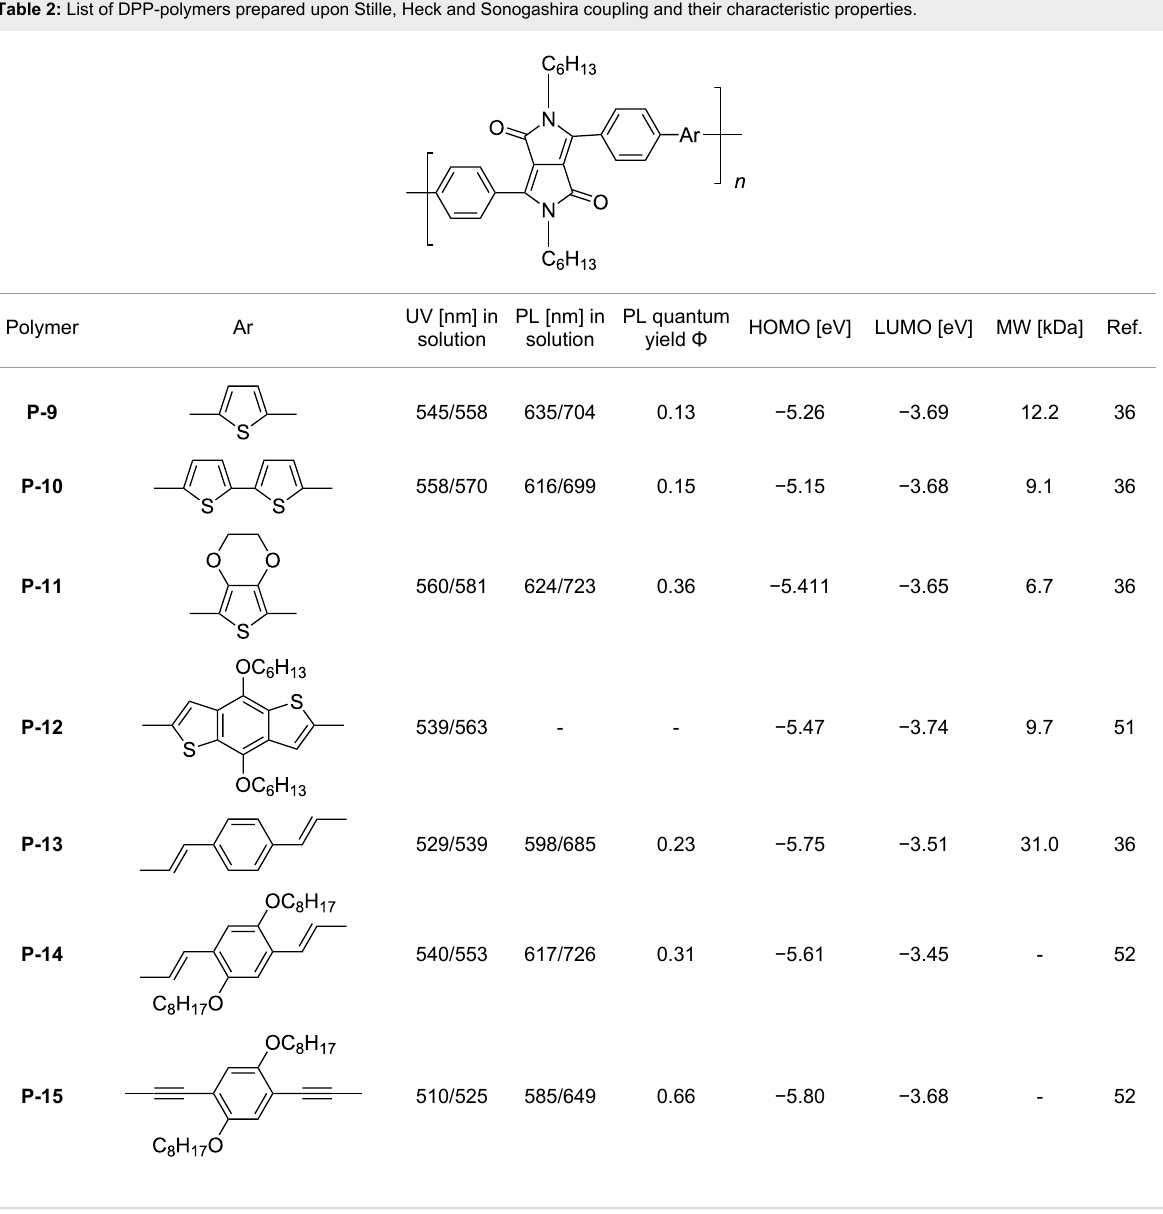
Table 1. Compared with the DPP monomers, the absorption